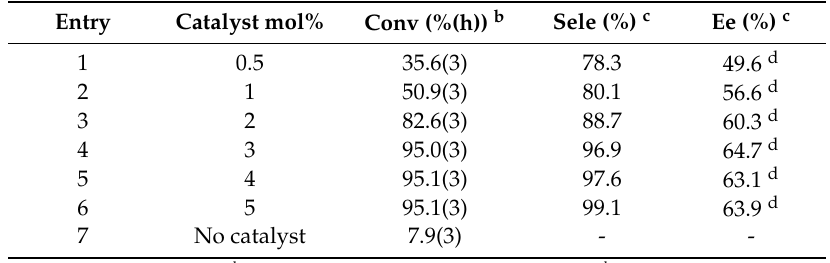
Table 2. The results of screening the quantity of catalyst 3 in the epoxidation of styrene a